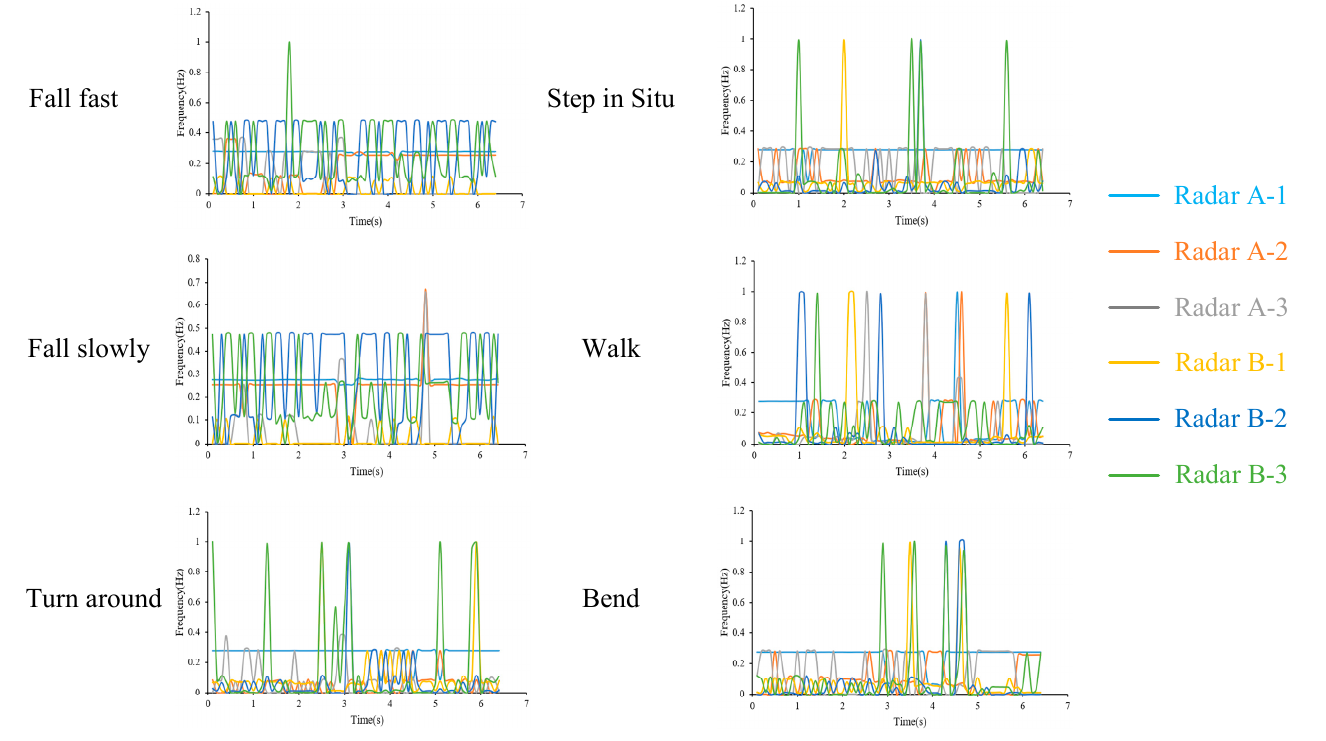
Figure 2. Parameters varying with time for six different